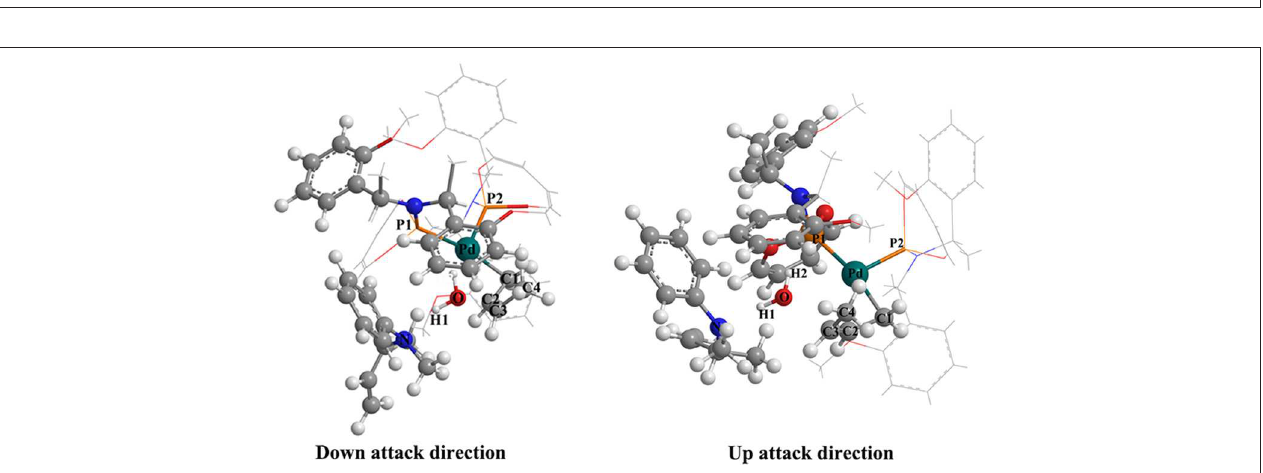
FIGURE 5 | Visualizing the structure of the TSI-IIb-R state (left picture) and the TSI-IIb-S state (right picture).